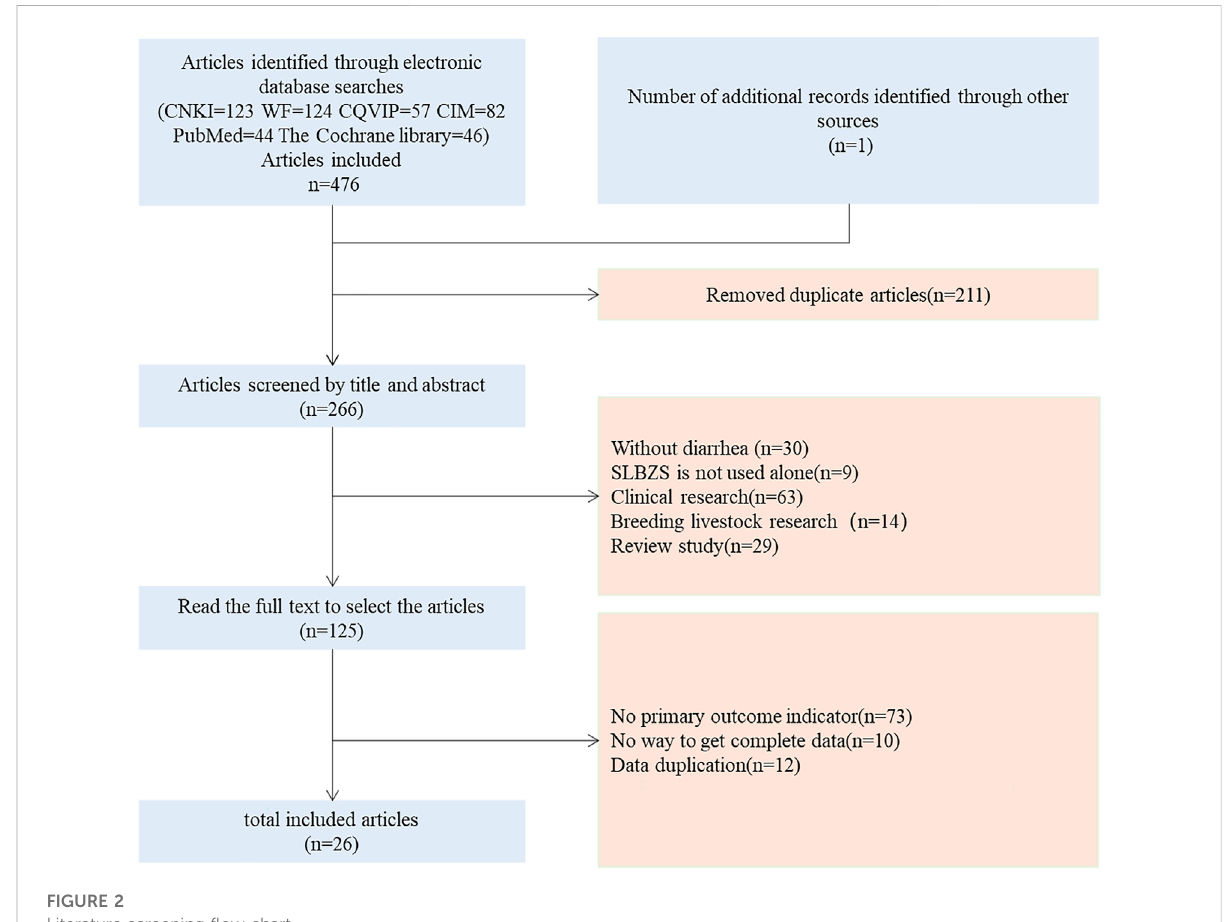
FIGURE 2 Literature screening fl ow